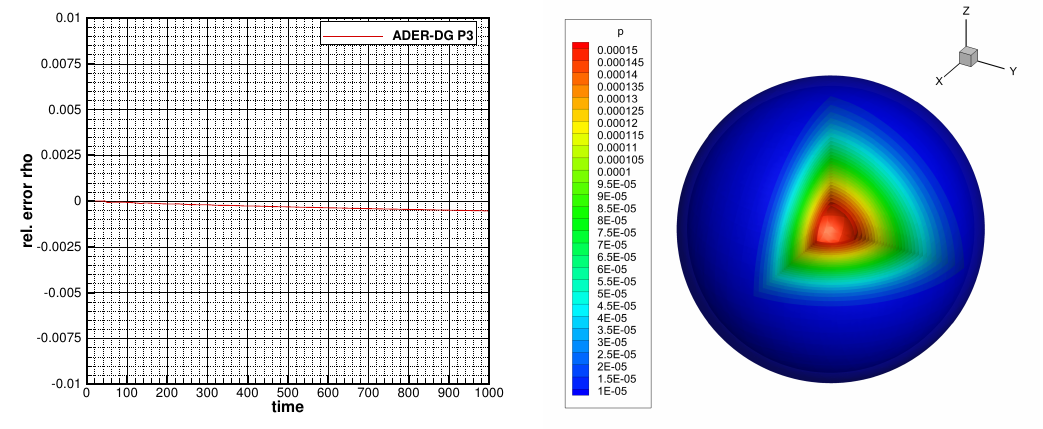
Figure 7. Computational results for a stable 3D neutron star. Time series of the relative error of the central rest mass density ( ρ ( 0 , t ) − ρ ( 0 ,0 )) / ρ ( 0 ,0 ) ( left ) and 3D view of of the pressure contour surfaces at time t = 1000 ( right